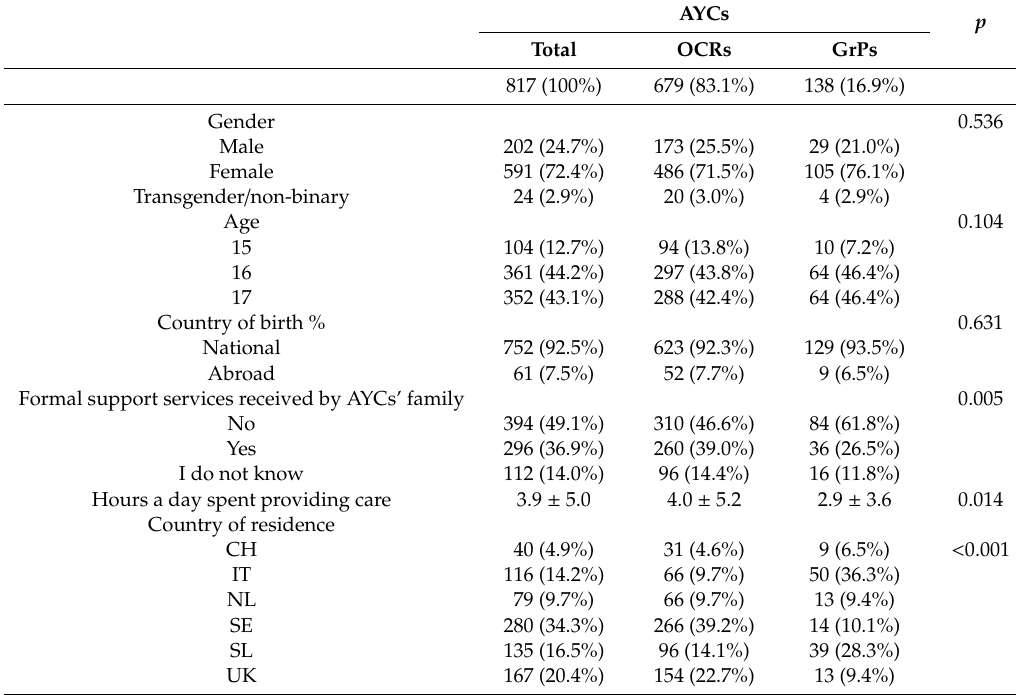
Figure 1. Procedure for the selection of the adolescent young carers (AYCs). Table 1. Sample characteristics according to the care recipients: AYCs of other care recipients (OCRs) and AYCs of grandparents